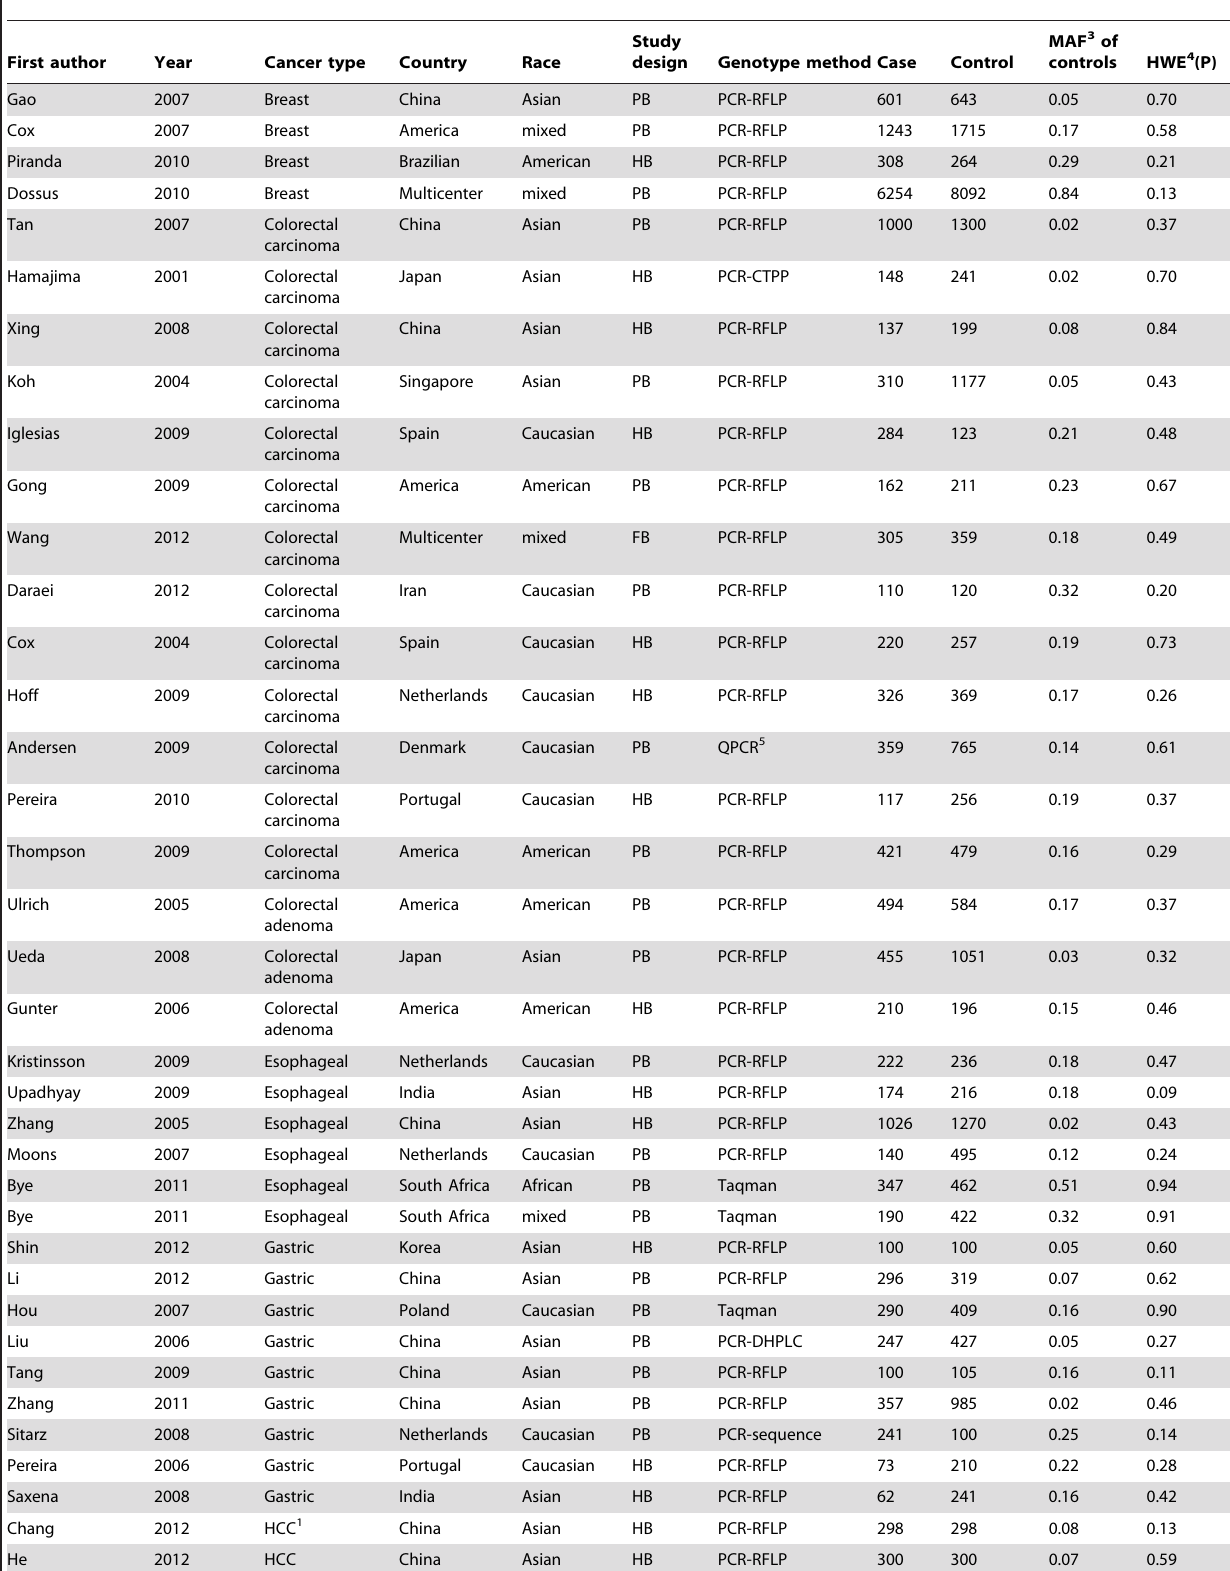
Table 1. Main characteristics of studies involved in this meta-analysis for an association between COX-2-765 G . C polymorphism and cancer